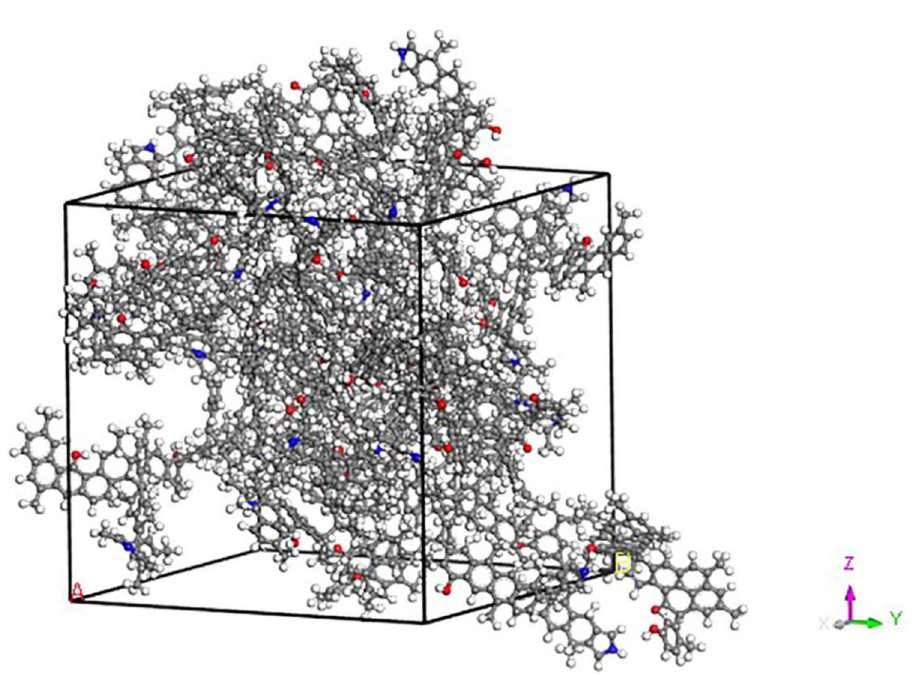
Figure 2. Model of coal